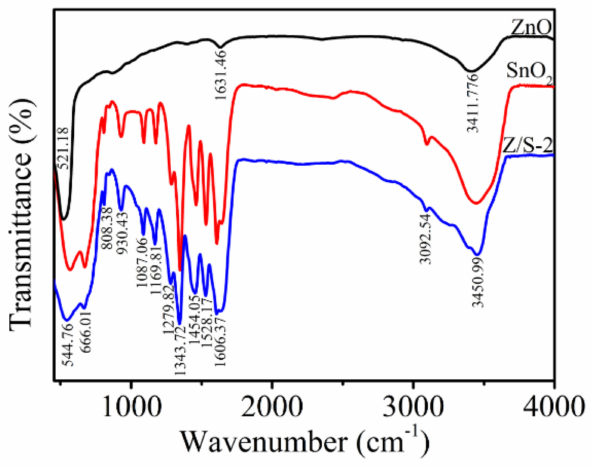
Figure 7. FTIR spectra of SnO 2 , ZnO, and Z/S-2